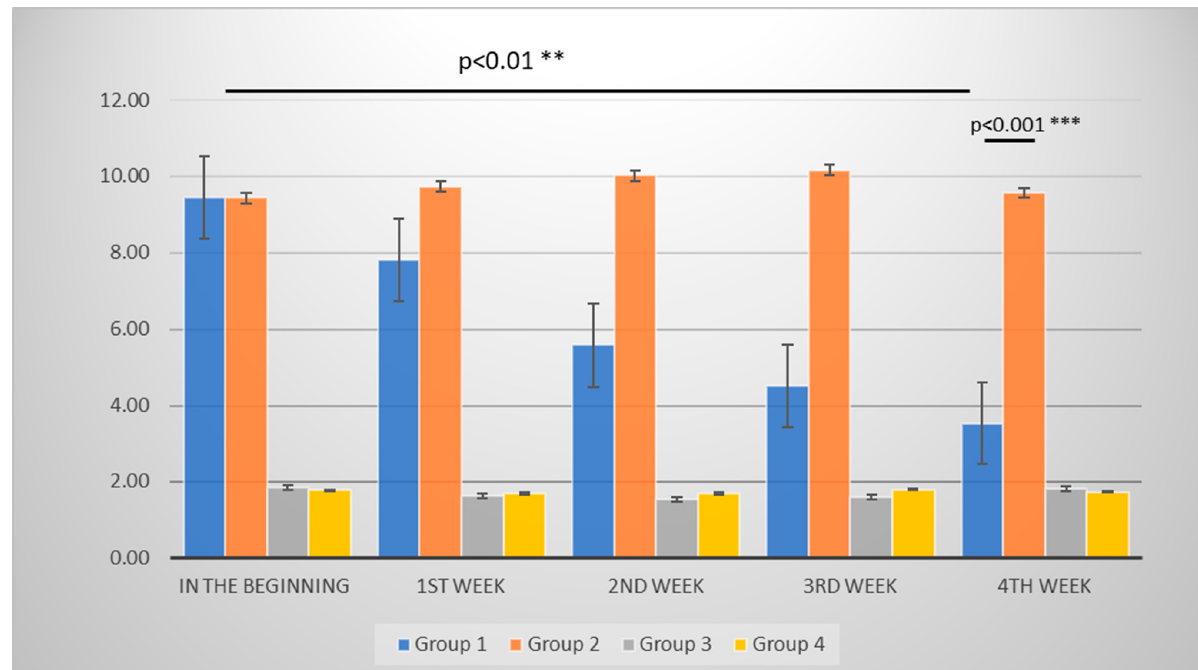
Figure 5. Mean levels of HOMA-index in the different groups during the study. Statistical significance: ** p < 0.01, *** p <